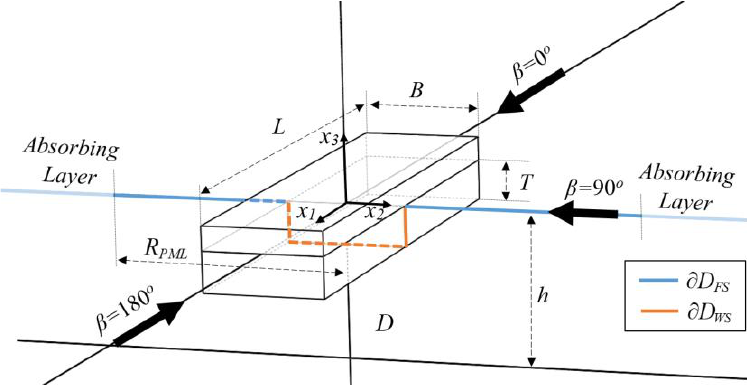
Figure 2. Elongated floating pontoon structure supporting photovoltaic panels and parameters of the hydrodynamic model.